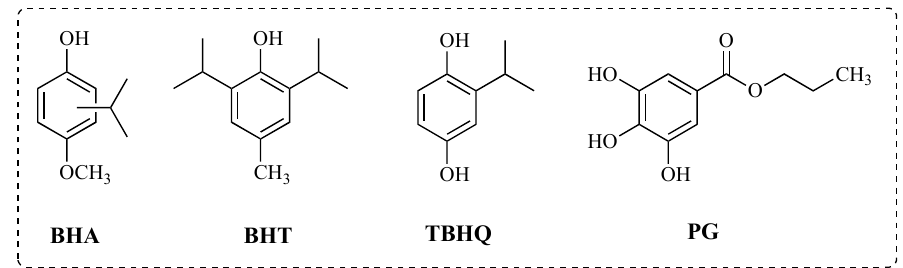
Figure 1. The chemical structures of the most commonly used synthetic antioxidants.